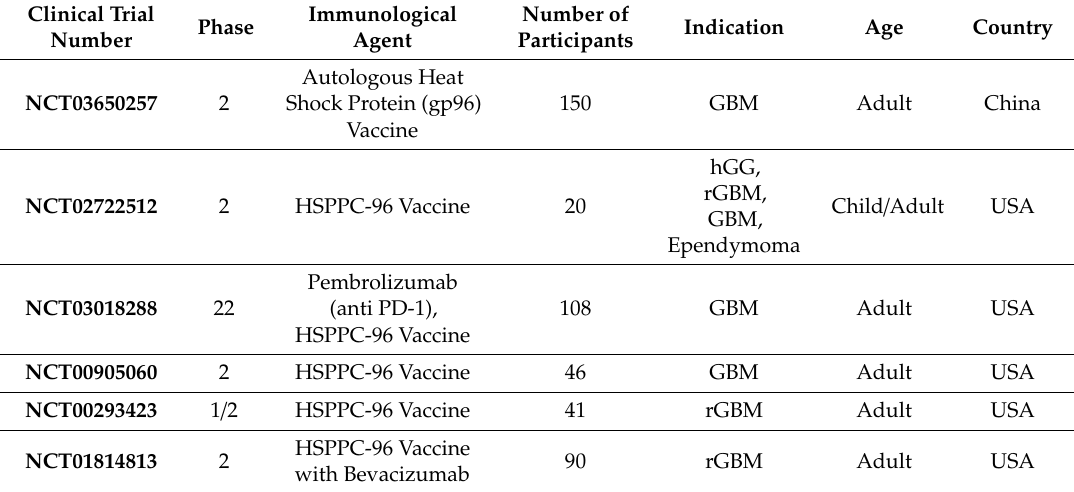
Table 4. Clinical trials concerning heat shock protein peptide complex (HSSPC) vaccination in glioblastoma-multiforme (GBM) patients. (https: // www.clinicaltrials.gov). Clinical